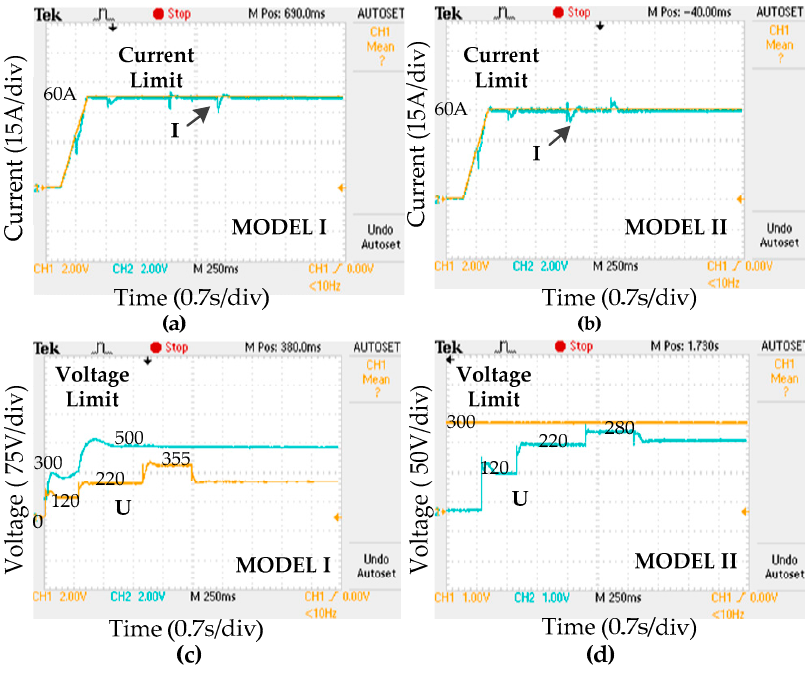
Figure 22. Results of current and voltage under the step change of the reference speed when the torque setpoint is 90 Nm. ( a ) actual current and the current limit of Model I; ( b ) actual current and the current limit of Model II; ( c ) actual voltage and the voltage limit of Model I; ( d ) actual voltage and the voltage limit of Model II.